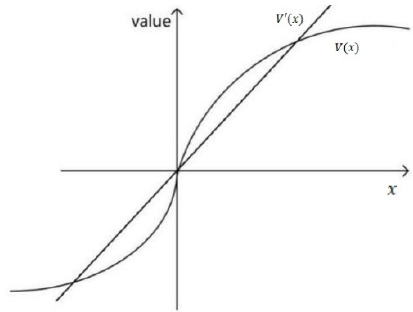
Figure 1. The diagram of the value function.